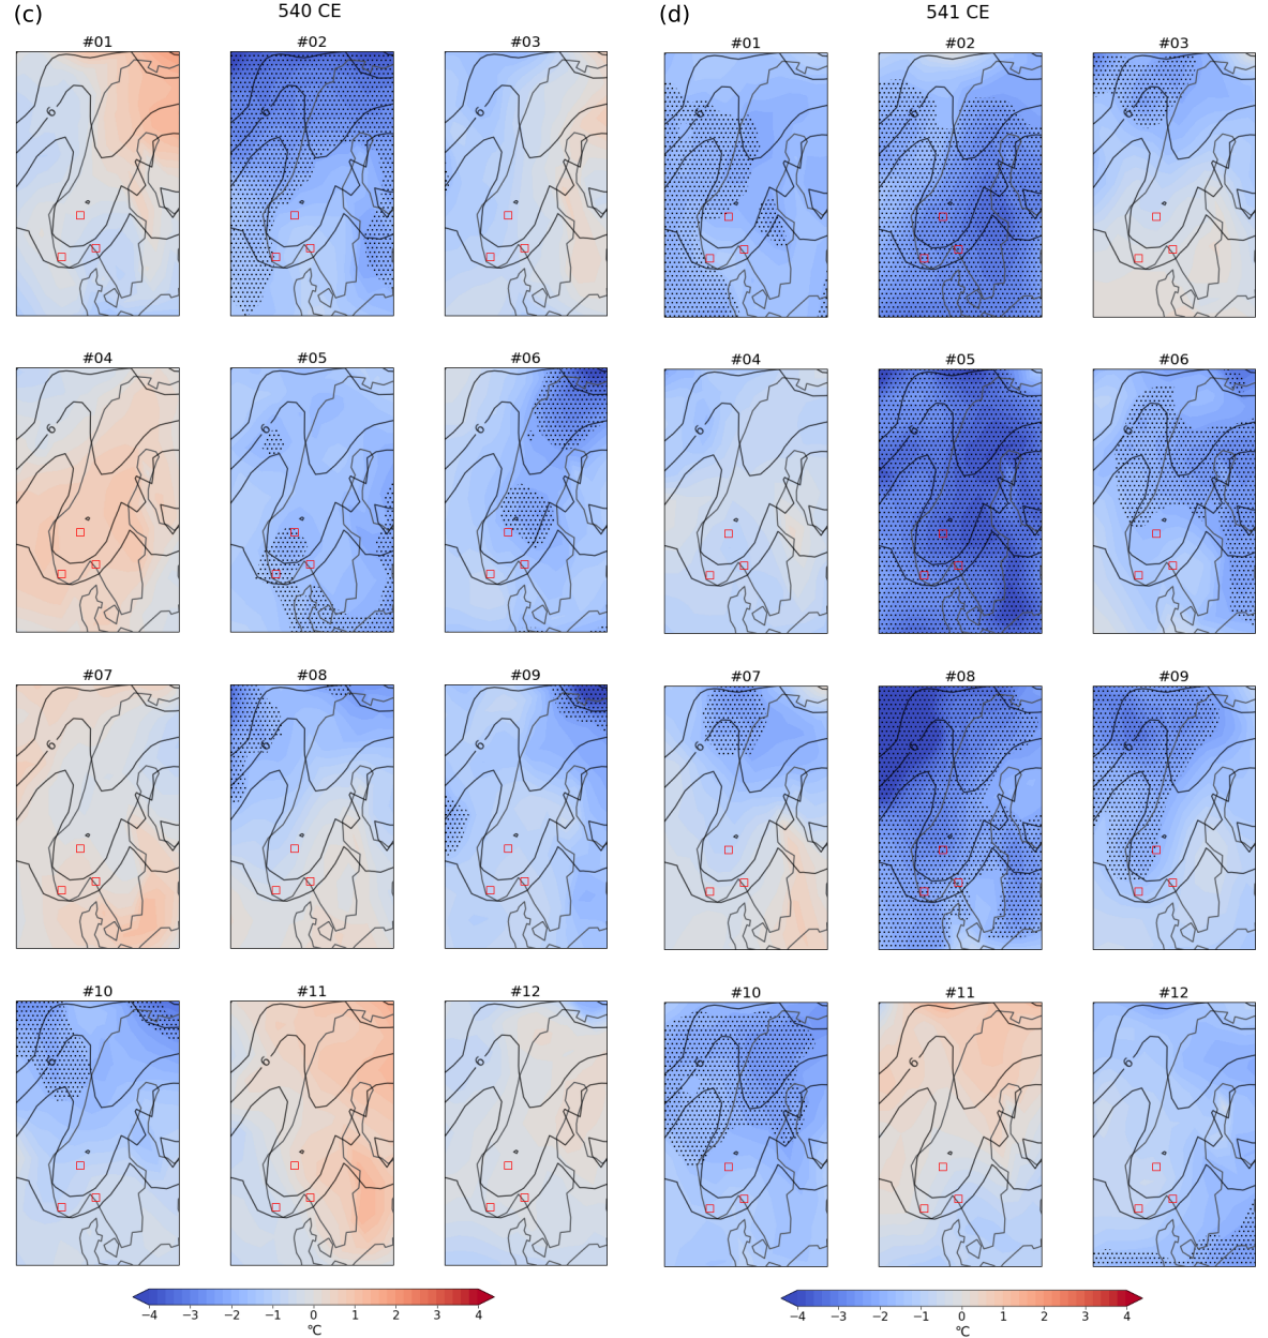
Figure A1. The 2m air temperature anomaly for the individual ensemble members of (a) 536CE, (b) 537CE, (c) 540CE, and (d) 541CE. Anomalies are calculated with respect to the 1–1850CE climatology in contours (1 ◦ C intervals). The red squares indicate the areas used for the growing degree day calculations. The 2 σ significant level is